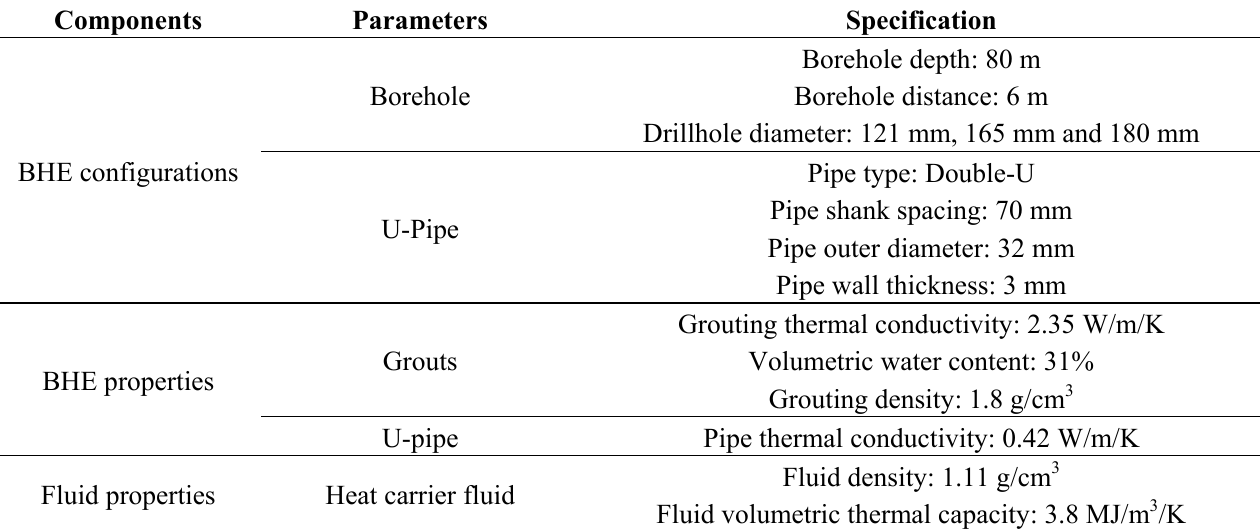
Table 3. Geometric configurations and material properties for the